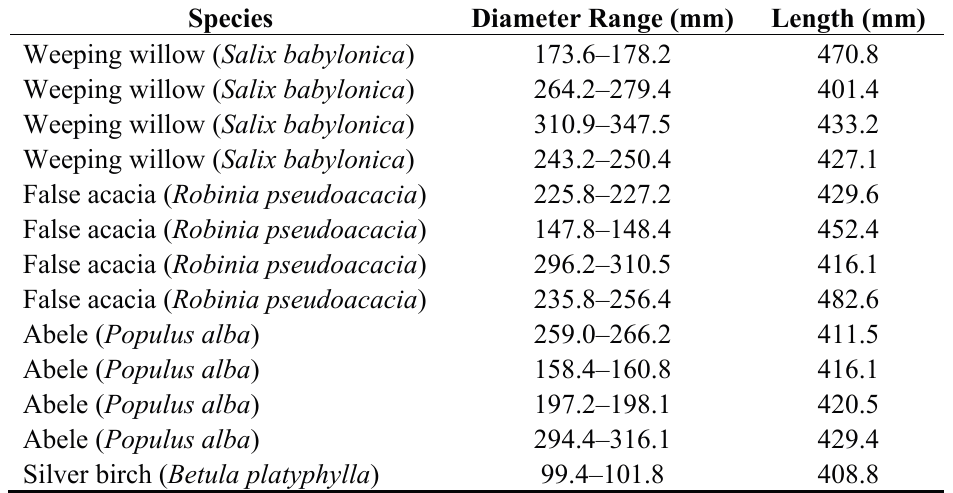
Figure 4. The thirteen tree trunks and the indoor experimental scene. Table 1. Tree species, diameter range and length of the trunk sections scanned in the